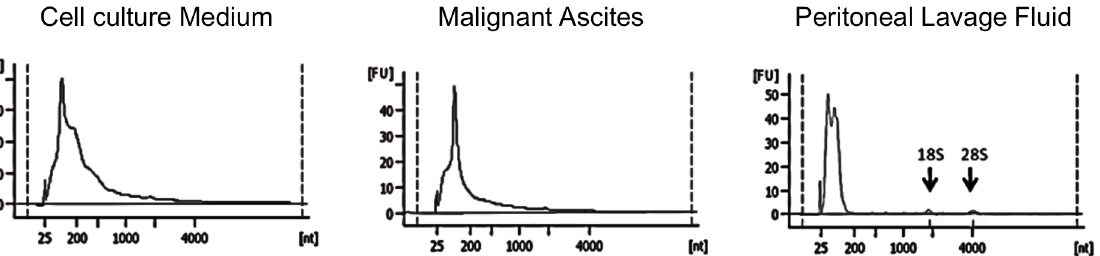
Fig 1. Exosomal miRNA expression in malignant ascites (MA), peritoneal lavage fluid (PLF), and cell culture media (CM). Variation and commonality between the samples were examined. Evaluation of total exosomal RNA used a Bioanalyzer 2100. The electropherograms show the size distribution (nucleotides, nt) and fluorescence intensity (FU) of total exosomal RNA isolated from CM, MA, and PLF. The lowest spike (around 25 nt) in each sample is the marker of the Agilent RNA 6000 Pico kit.